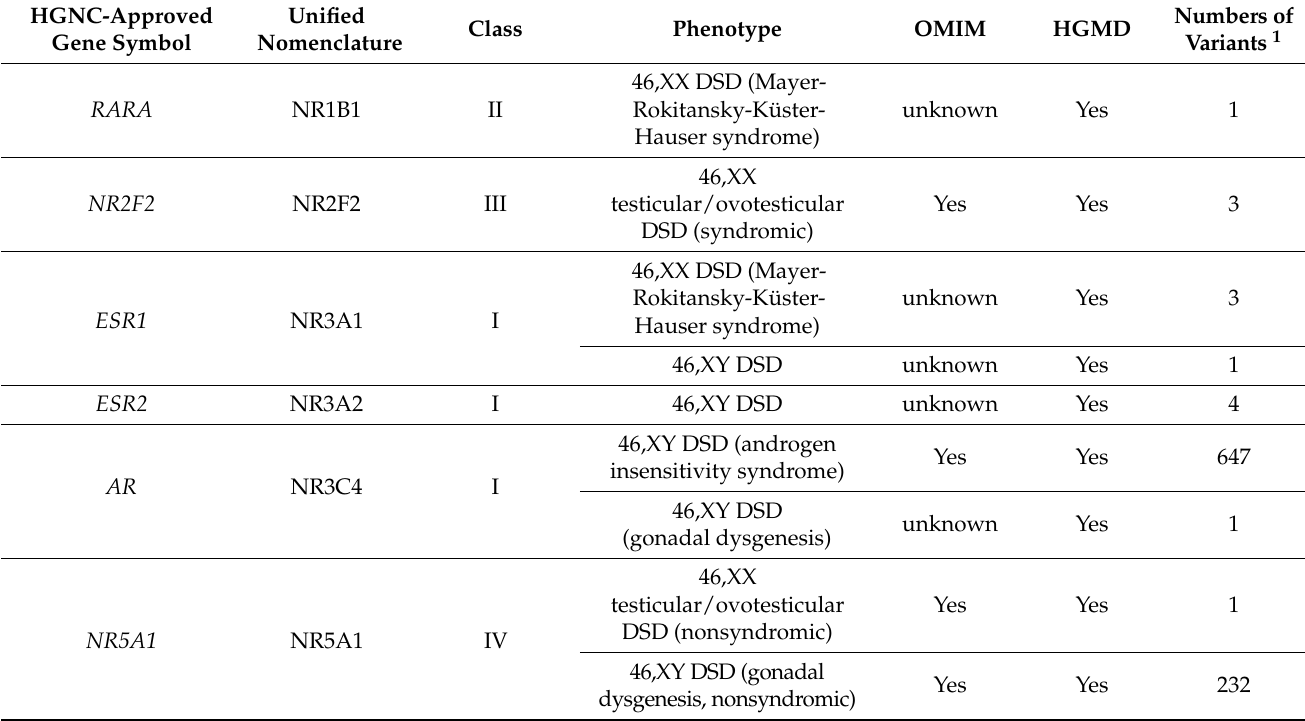
Table 1. Nuclear receptor-encoding genes that are linked to disorders/differences of sex development (DSD) at OMIM or